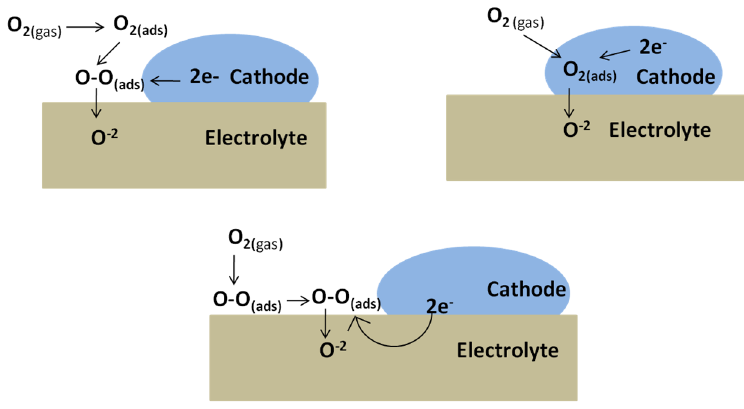
Figure 3. Three reaction pathways of oxygen reduction.